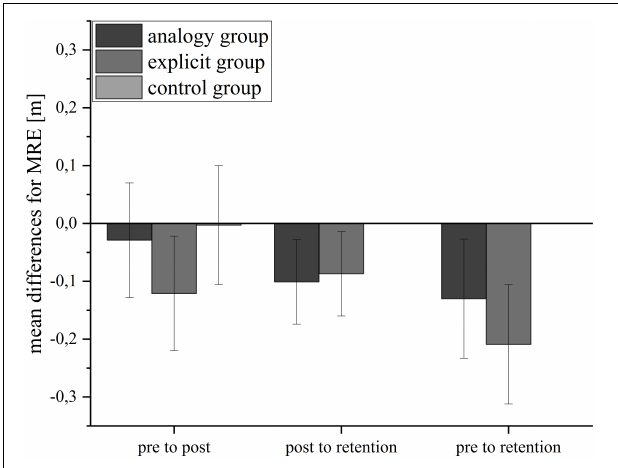
FIGURE 1 | Mean differences for mean radial error (MRE) in meters for the three groups from pretest to posttest, posttest to retention test, and from pretest to retention test. Error bars represent standard errors.